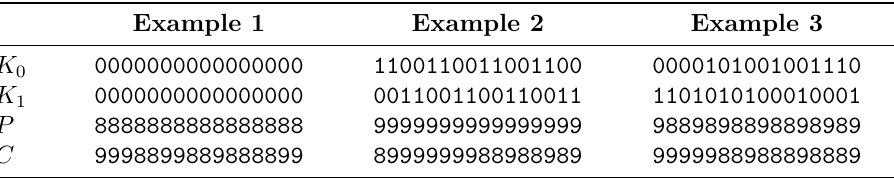
Table 2: Experimental